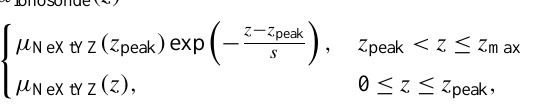
Figure 1. TomoScand receiver network and the satellite overflight ground track with four EISCAT UHF scan